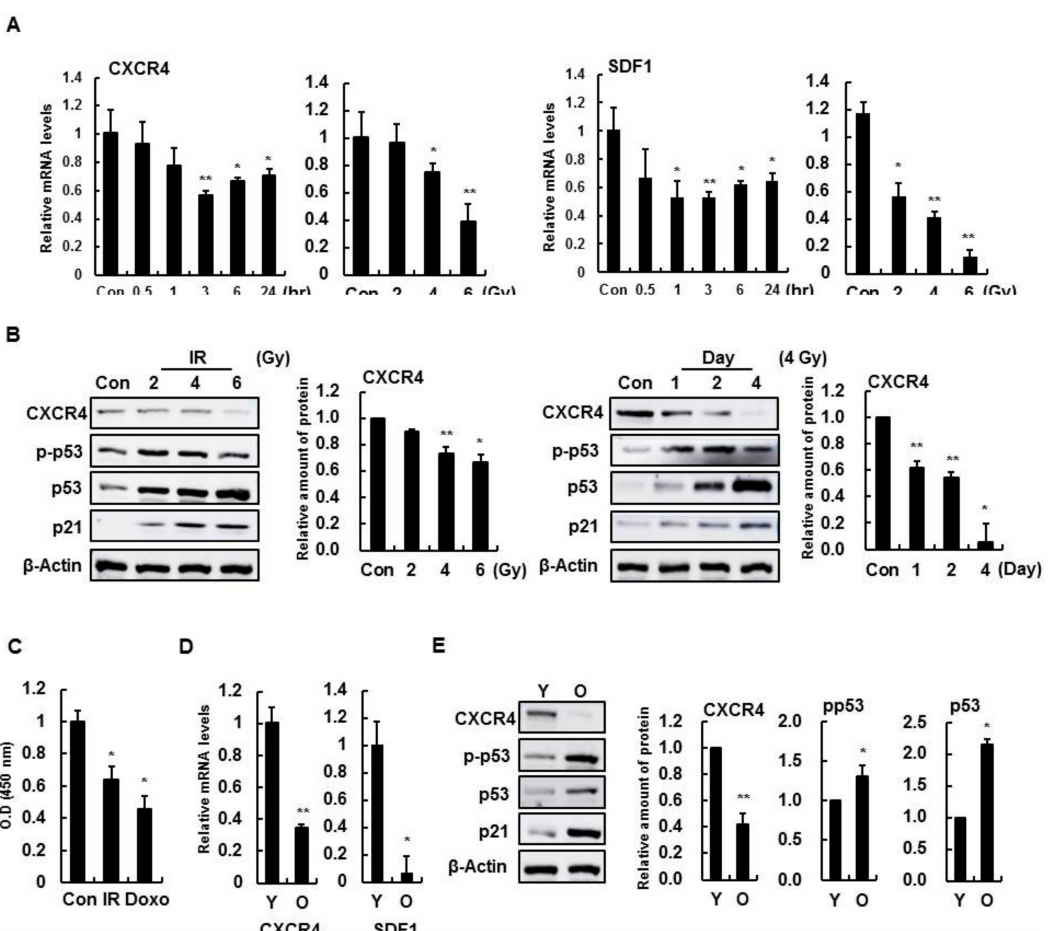
Figure 1. Induction of cell damage in human brain microvascular endothelial cells (HBMVECs) reduces CXC chemokine receptor 4 (CXCR4) and stromal cell-derived factor 1 (SDF-1). ( A ) HBMVECs were treated with IR (4 Gy) for 0, 0.5, 1, or 3 h with increasing ionizing radiation (IR) concentrations for 24 h. CXCR4 and SDF-1 expression levels were measured using real-time polymerase chain reaction (PCR). ( B ) Protein levels of CXCR4, phospho-p53, p53, and p21 were confirmed in radiation-treated HBMVECs with the indicated antibodies in a Western blot analysis. ( C ) HBMVECs were treated with 4 Gy radiation or 1 µ M / mL doxorubicin for 24 h, and the secreted SDF-1 protein level was measured with cell supernatants using an enzyme-linked immunosorbent assay (ELISA) analysis. ( D ) Expression levels of CXCR4 and SDF-1 were determined by real-time PCR in senescent HBMVECs. ( E ) Protein levels of CXCR4 were also confirmed by Western blot analysis in senescent HBMVECs. Values are expressed as the mean ± standard deviation of three independent experiments. * p < 0.05 and ** p < 0.01. IR, ionizing radiation; Doxo, doxorubicin; Y, young cell; O, old cell; Con, control; CXCR4, CXC chemokine receptor 4; SDF-1, stromal cell-derived factor 1; HBMVEC, human brain microvascular endothelial